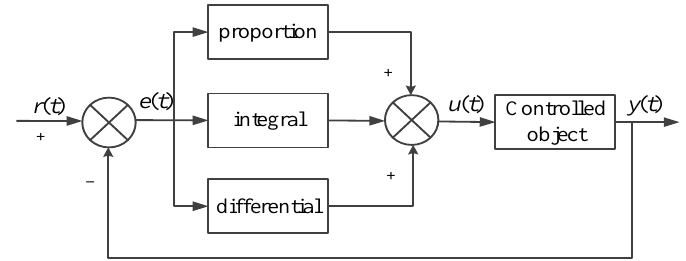
Figure 6. PID control schematic diagram. actual acceleration a